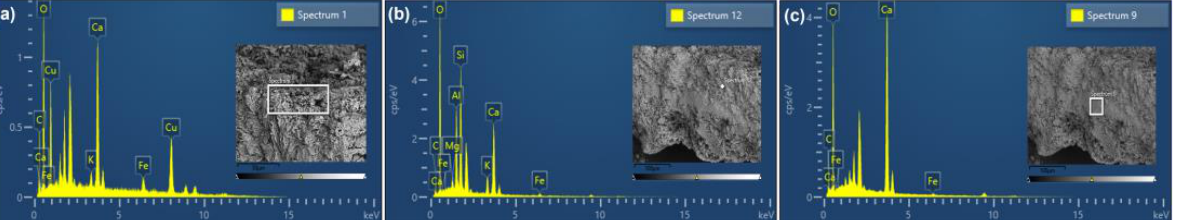
Figure 8. Result of Energy Dispersive Spectroscopy (EDS) of a part of mural sample. ( a ) Painting layer. ( b ) Ground layer. ( c ) The semitransparent layer beneath the ground layer.